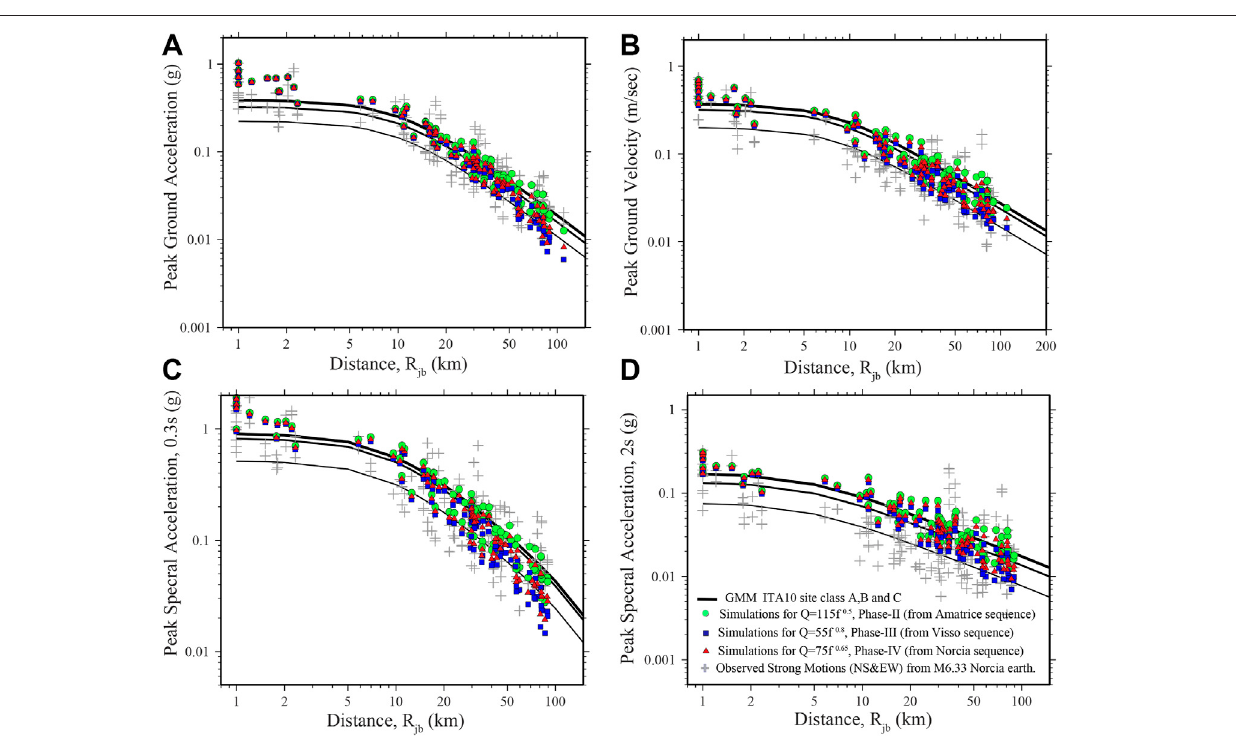
FIGURE 6 | (A) Predictions of peak ground acceleration (PGA) for the Norcia mainshock (M6.3) (colored symbols) and comparison with the observed data (gray crosses). Solid black lines refer to Bindi et al. (2011) for sites, A, B, and C classes. Simulation are generated using 1) three different attenuation parameters; Q( f )=105 f 0.5 hase-II, from the Amatrice earthquake sequence; Q( f )=55 f 0.8 phase-III, from the Visso earthquake sequence; Q( f )=75 f 0.65 phase-IV, from the Norcia earthquake sequence and, and 2) geometrical spreading coef fi cient g(r)=1.0, R < 40 km and g(r)=0.5 for R > 40 km, 3) a stress drop parameter Δσ = 20 MPa and 4 ) κ 0 = 0.025s, 0.035s and 0.045s for sites, A, B, and C classes (B,C,D) same as in frame (a) but for peak ground velocity (PGV), pseudo spectral accelerations at 0.3 and 2